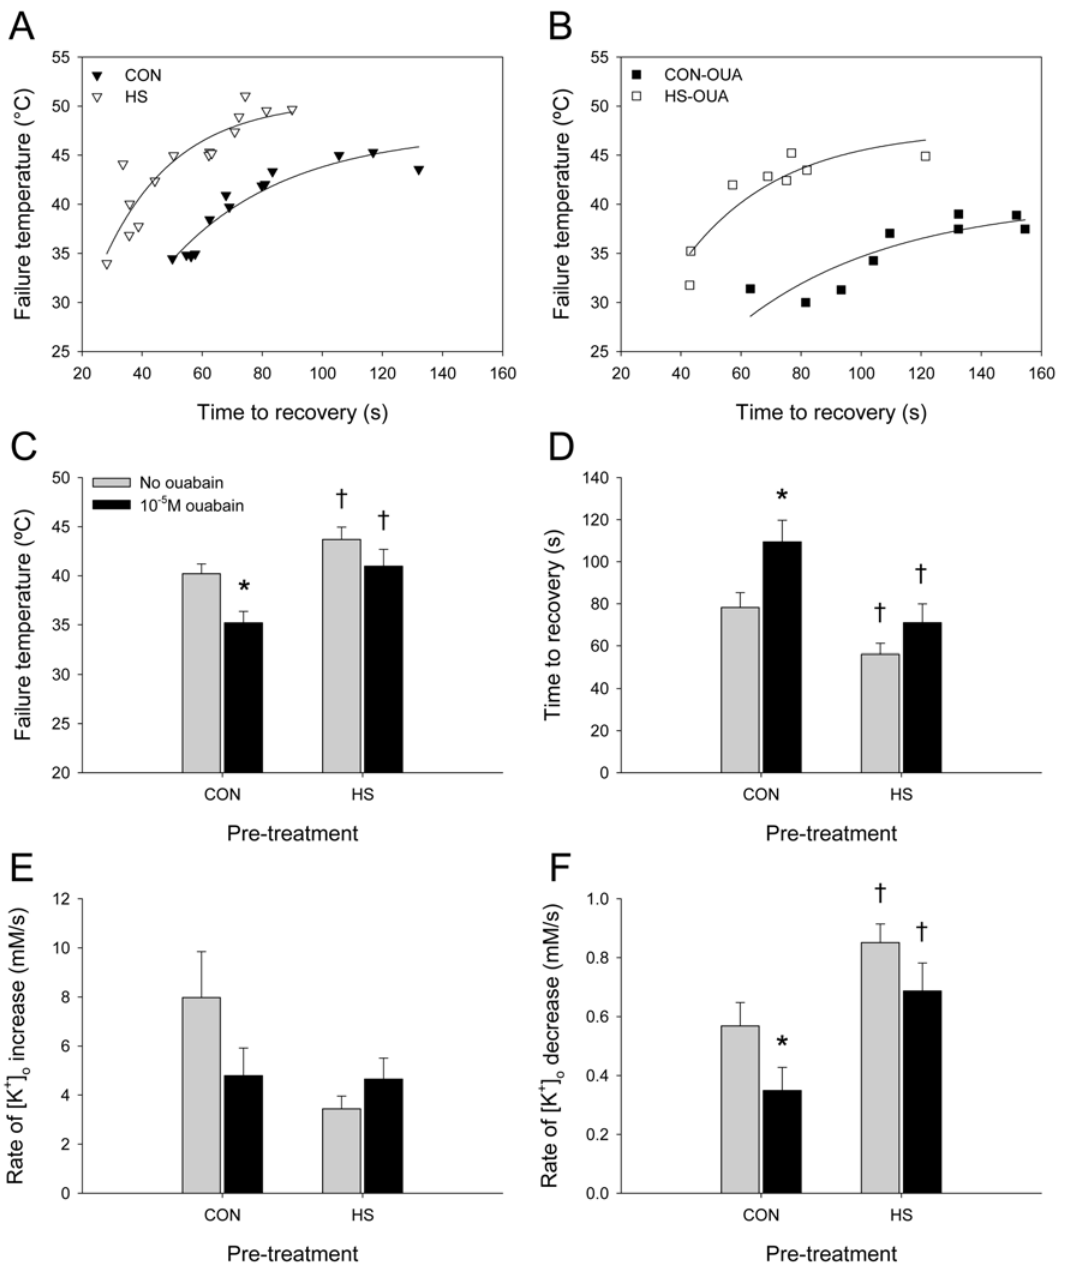
Figure 7. HS delays the [K + ] o event and speeds recovery by increasing the rate of [K + ] o clearance. A. Time to recovery was positively correlated with failure temperature in CON and HS locusts (N CON =13; N HS =15). Animals whose ventilatory motor pattern failed at a higher temperature had a longer time to recovery when temperature returned to normal levels. B. The correlations seen in CON and HS animals were shifted in animals treated with 10 2 5 M ouabain (N CON-OUA= 9; N HS-OUA= 8). The relationship between failure temperature and time to recovery in HS-OUA animals resembled CON animals. Data points for each group were fitted with exponential curves that rise to a plateau ( A, B ). C. Ventilatory motor pattern generation in HS locusts failed at a significantly higher temperature than in CON locusts with and without 10 2 5 M ouabain treatment. There was a significant effect of ouabain on the ability to withstand high temperature stress in CON locusts but not in HS locusts (N CON =15; N CON-OUA =9; N HS =17; N HS-OUA =8). D. Ventilatory motor pattern generation in HS locusts took significantly less time to recover following heat-induced failure than in CON locusts with and without ouabain treatment. CON-OUA locusts took significantly more time to recover than CON locusts, however there was no significant effect of ouabain treatment on time to recovery in HS locusts (N CON =13; N CON-OUA =10; N HS =15; N HS-OUA =8). E. Overall there were no main effects of HS pre- treatment or ouabain treatment on the rate of [K + ] o increase (mM/s) associated with failure of the motor pattern (N CON =15; N CON-OUA =10; N HS =18; N HS-OUA =7). F. The rate of [K + ] o decrease (mM/s) associated with recovery of the motor pattern was significantly greater in HS locusts than in CON locusts and this effect of pre-treatment was conserved in ouabain-treated locusts. Ouabain treatment significantly decreased the rate of [K + ] o clearance in CON locusts but not in HS locusts (N CON =15; N CON-OUA =10; N HS =18; N HS-OUA =8). Asterisks indicate a significant effect of ouabain and daggers indicate a significant effect of pre-treatment according to post hoc Tukey tests ( P , 0.05) ( C–F ).